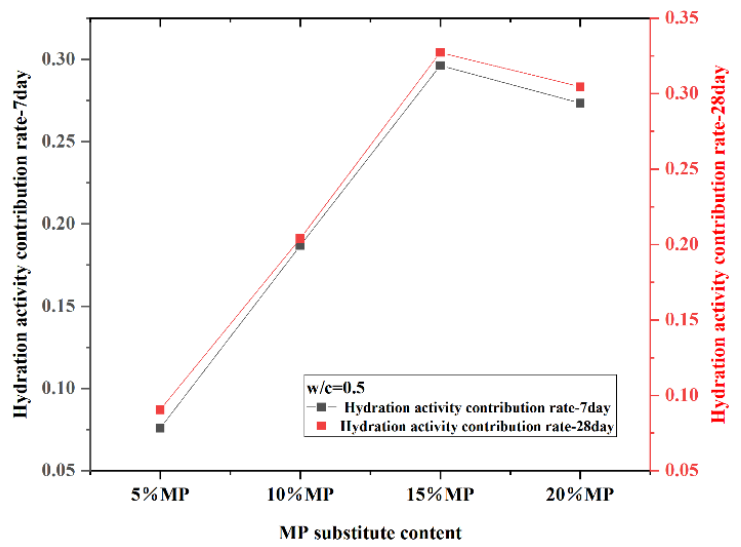
Figure 15. Differentiation of 7-day and 28-day hydration activity contribution rate at different MP contents.